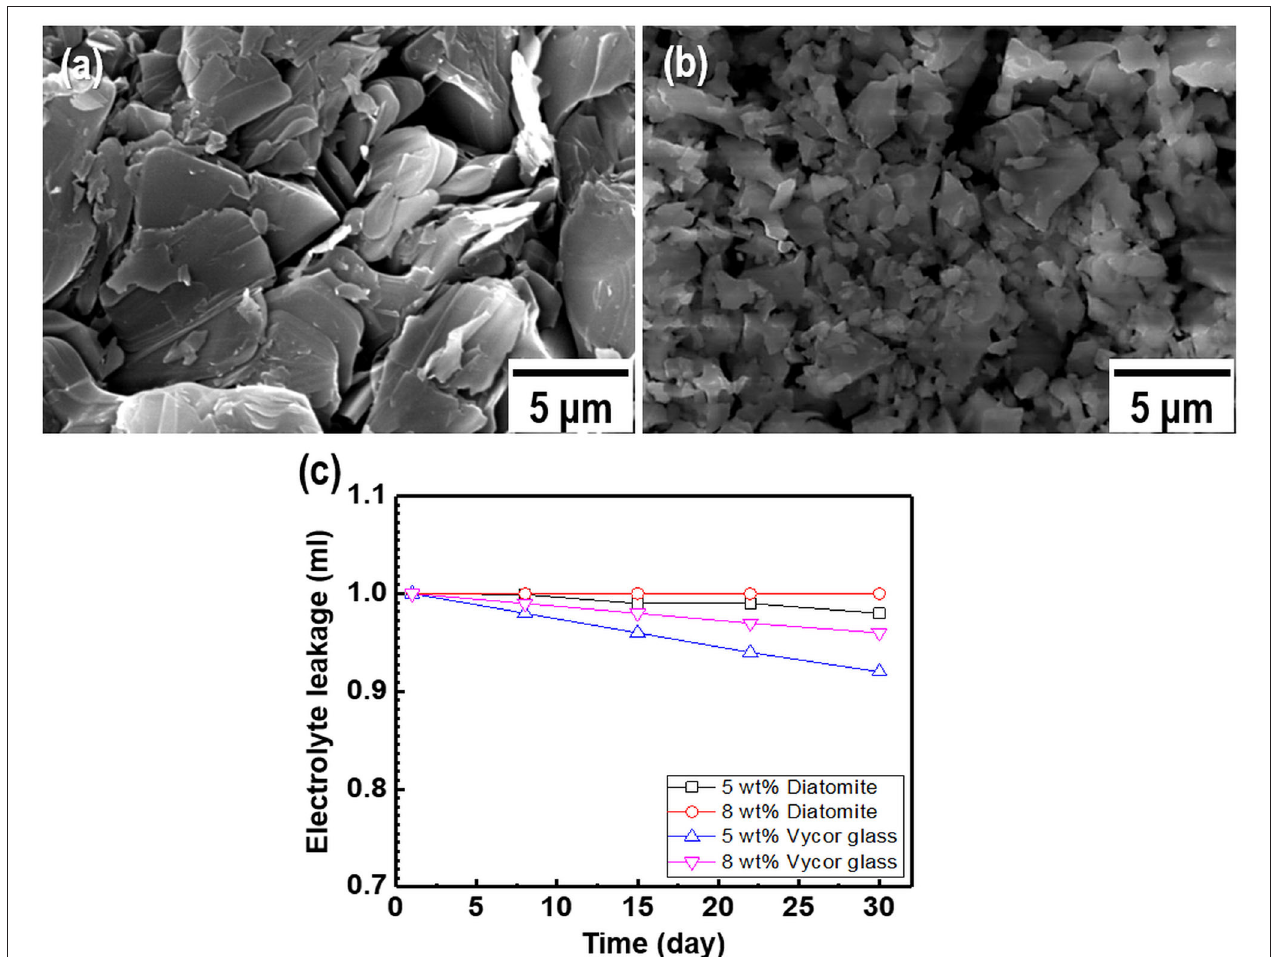
FIGURE 3 | Field-emission scanning electron microscopy (FE-SEM) images of two types of membranes: (a) Vycor glass membrane and (b) as-synthesized diatomite ceramic membrane. (c) Internal electrolyte leakage data for the membranes as a function of